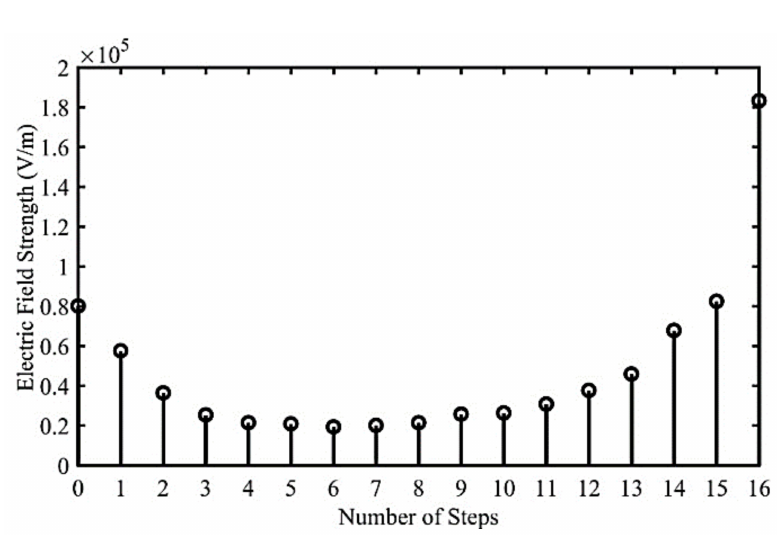
Figure 15. Line plot of bentonite bauxite.